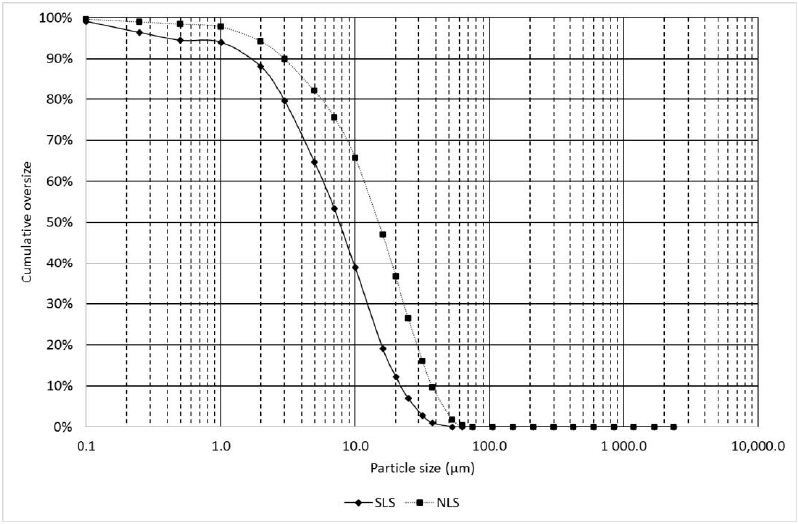
Figure 17. Particle size distribution of the ( − 63 µm) fractions obtained by size classifications for SLS and NLS sediments on the SOLINDUS platform.